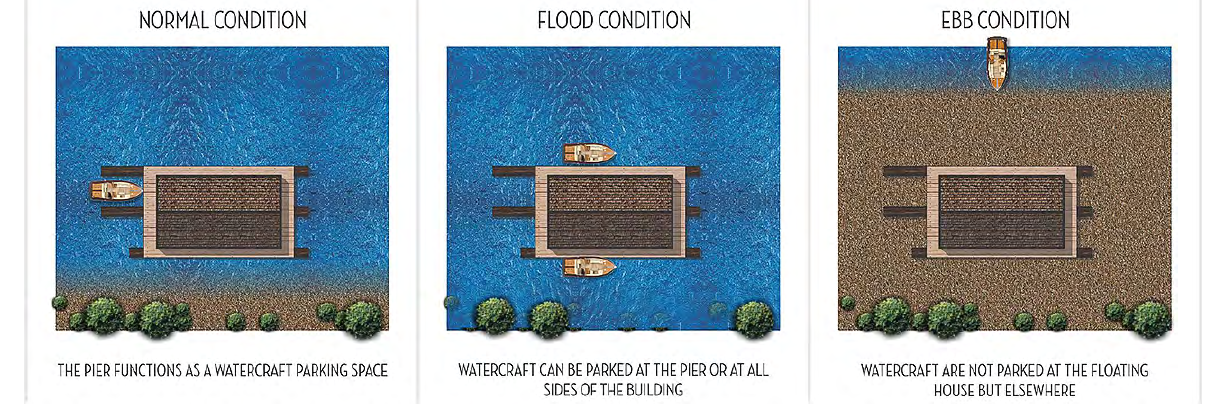
Figure 20. Function modification in floating